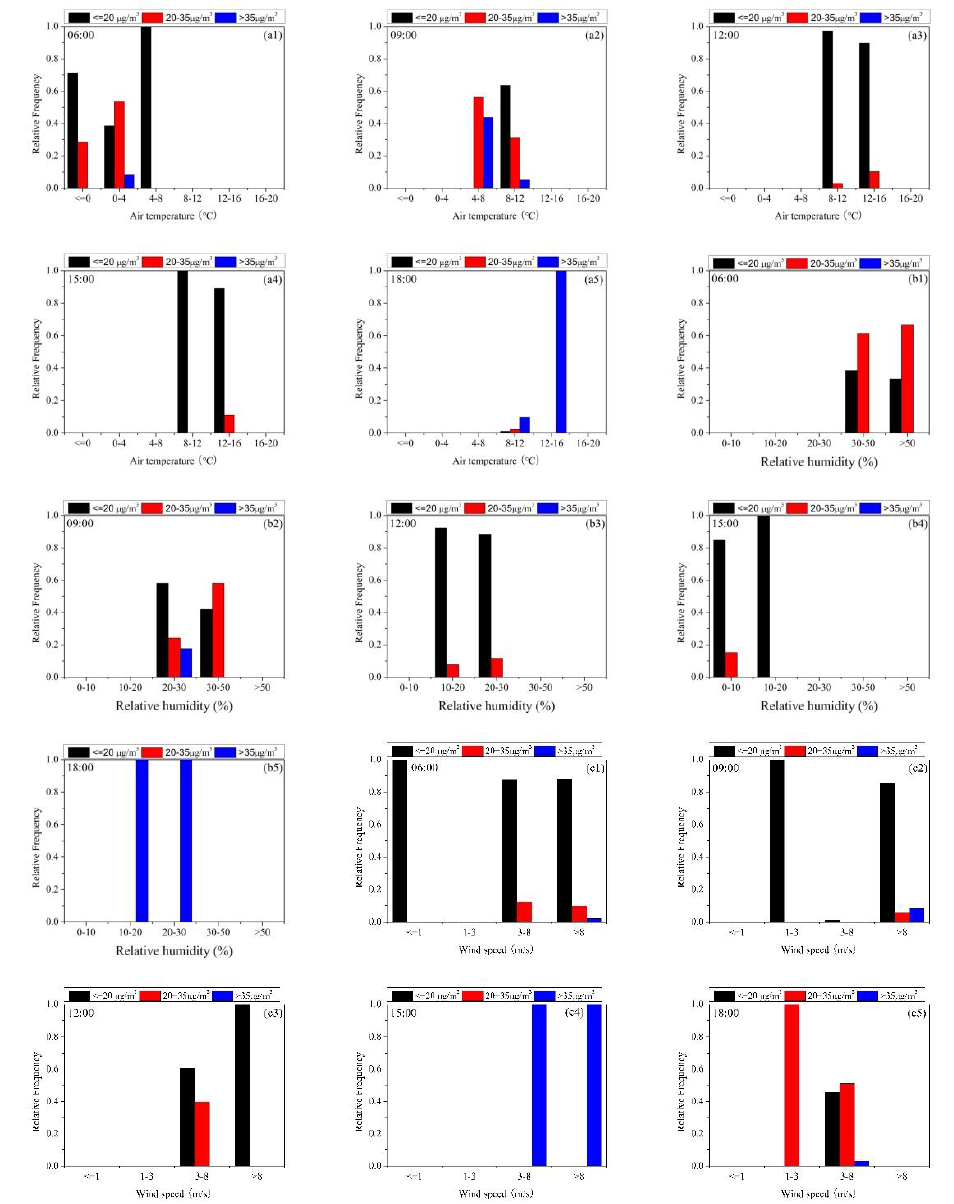
Figure 10. Histograms of the air temperature ( a1 : 06:00, a2 : 09:00, a3 : 12:00, a4 : 15:00, and a5 : 18:00), relative humidity ( b1 : 06:00, b2 : 09:00, b3 : 12:00, b4 : 15:00, and b5 : 18:00), and wind speed ( c1 : 06:00, c2 : 09:00, c3 : 12:00, c4 : 15:00, and c5 : 18:00) for different PM concentrations (black columns are ≤ 20 µ g · m − 3 , red columns are 20–35 µ g · m − 3 , blue columns are > 35 µ g · m − 3 ) during the observation periods at Xiaotang.